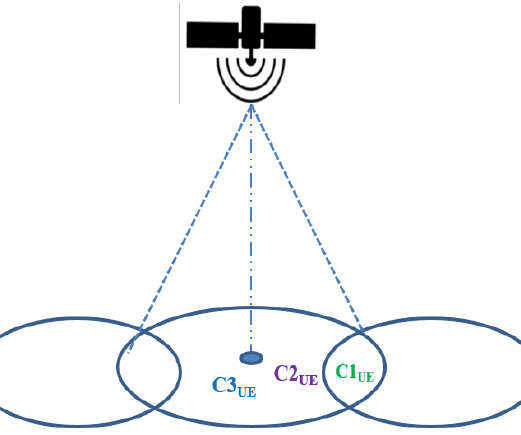
Figure 3. The proposed intra-satellite handover architecture.